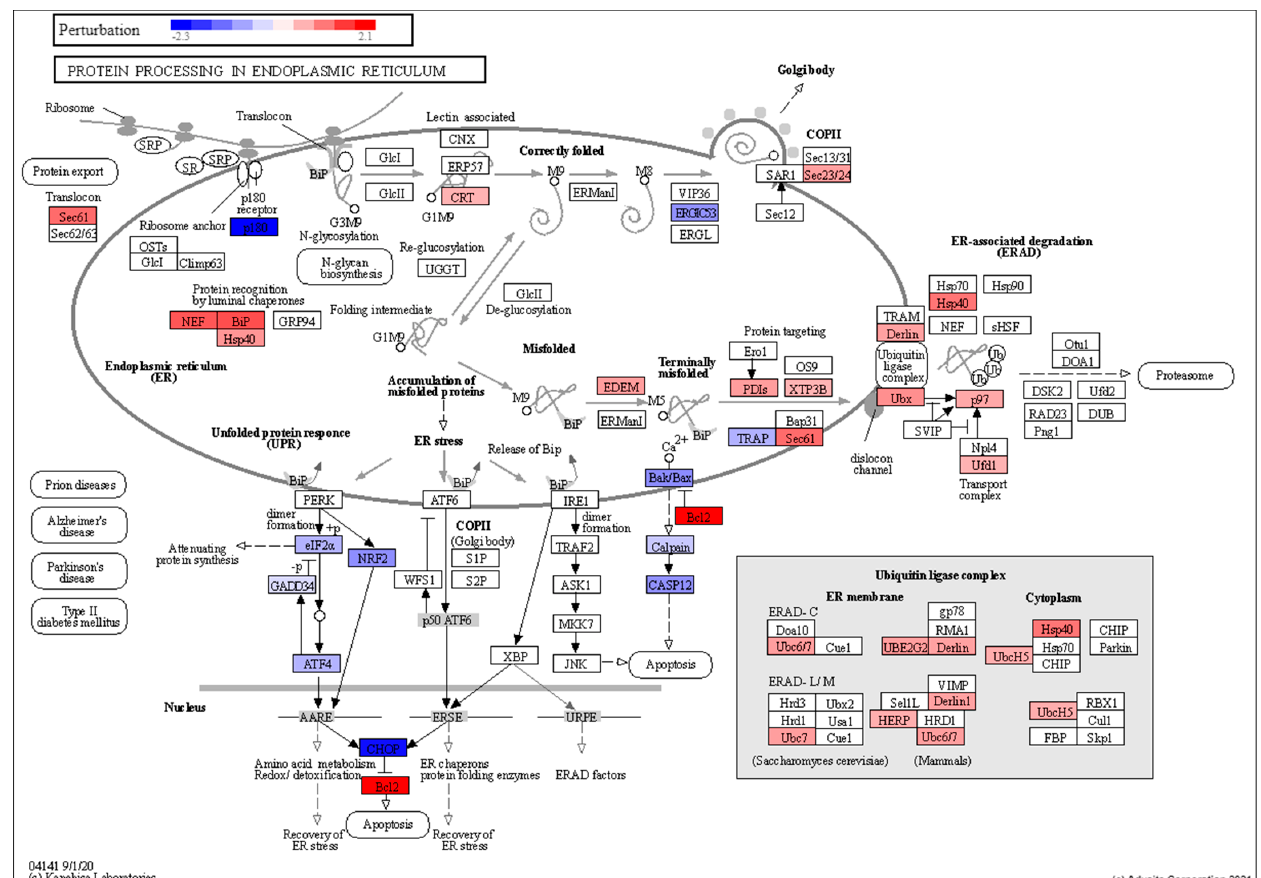
Figure 9. Perturbation of genes encoding proteins involved in ER-associated protein degradation showing an increase in expression of chaperones involved in detecting misfolded proteins ( NEF, BiP, Hsp40 ), as well as those involved in the ER-associated degradation pathway ( Derlin, UBx ). This also shows an increase in anti-apoptotic genes ( BCL2 ) and a decrease in pro-apoptotic genes ( Casp12 ). RED: upregulated, BLUE: downregulated.